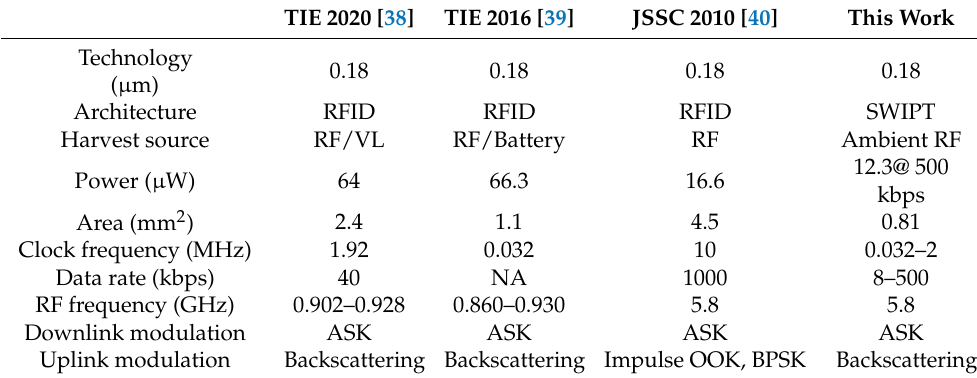
Table 2. Performance comparison with